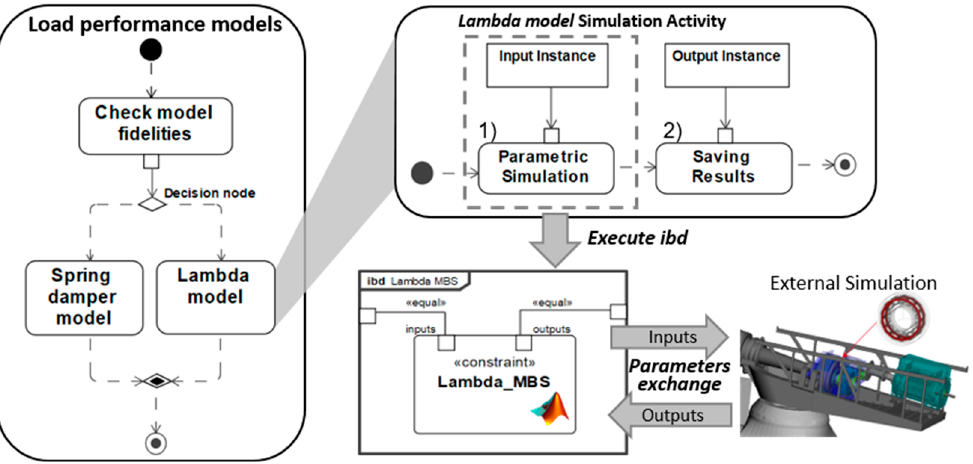
Figure 6. Handling simulation results to support up-to-date data during virtual testing .